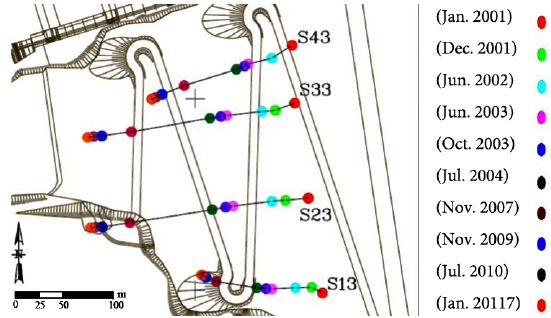
Fig. 2. Direction and value of horizontal displacements of geodetic stations